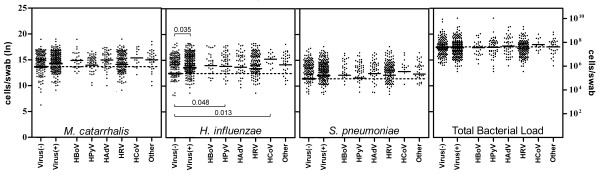
Bacterial Loads in the presence of common respiratory viruses. Significantly higher load was found for H. influenzae in the presence of any study virus, HPyV and HCoV, compared to no viral co-infection. The dotted line represents the baseline mean load in the absence of viral co-infection.